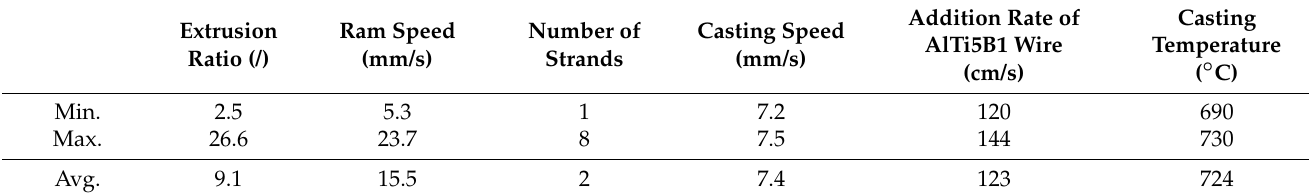
Table 2. Minimum, maximum, and average values for different process parameters.